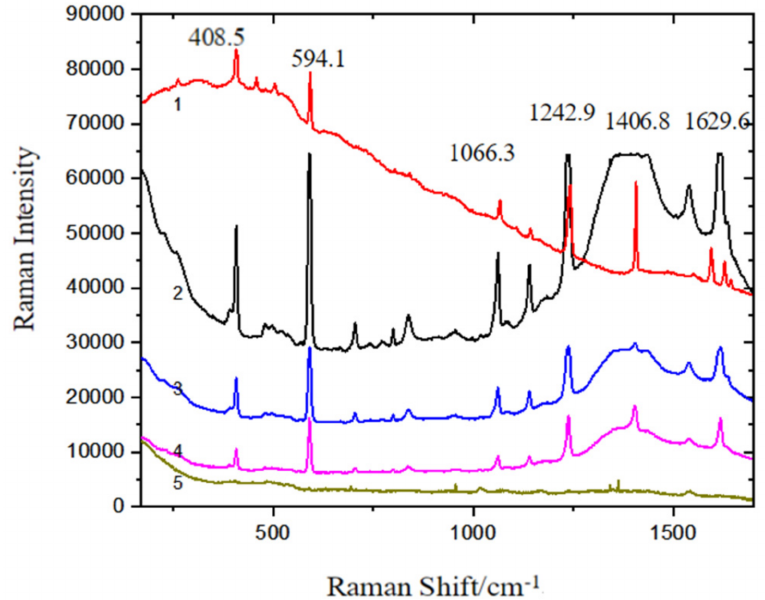
Figure 10. The detection limit of Pyrene captured on Fe 3 O 4 @PDA@Ag@GO nanocomposites SERS substrate (1) Pyrene solid; (2) 10 − 5 g/L Pyrene SERS solution; (3) 10 − 6 g/L Pyrene SERS solution; (4) 10 − 7 g/L Pyrene SERS solution; (5) 10 − 8 g/L Pyrene SERS solution.